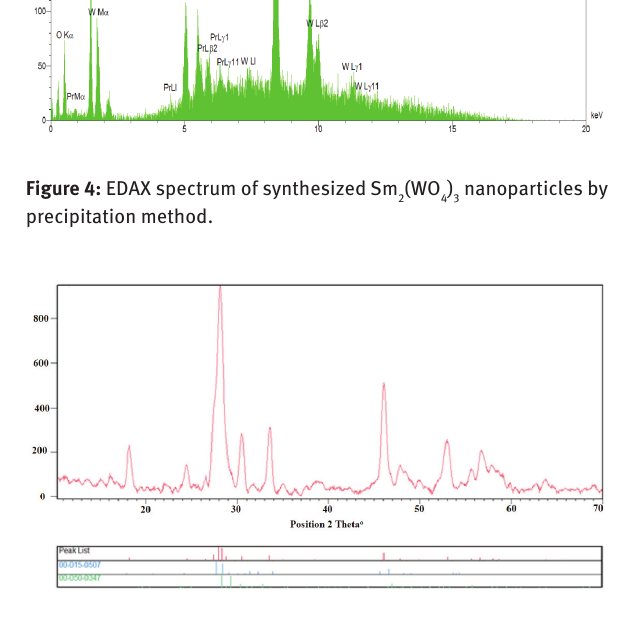
(WO ) nanoparticles by 2 4 3